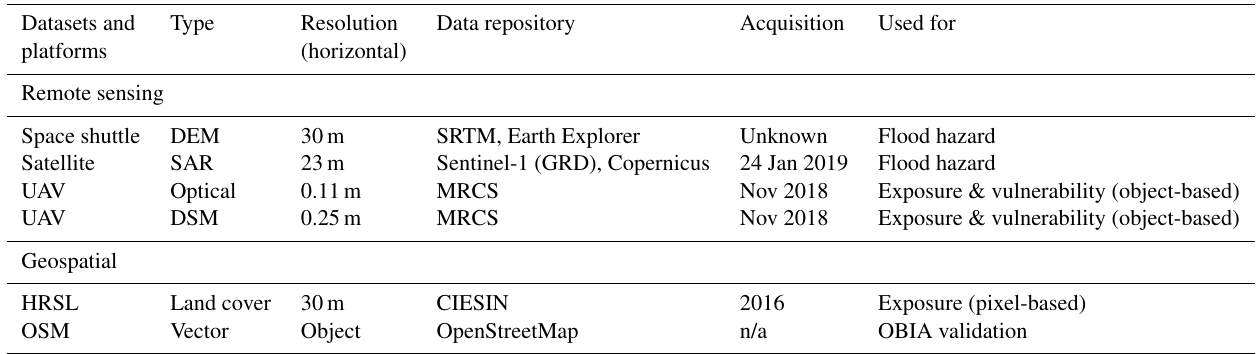
Table 1. Available datasets in this research. Abbreviations: digital elevation model (DEM), digital surface model (DSM), ground range detected (GRD), Malawi Red Cross Society (MRCS), OpenStreetMap (OSM) and Shuttle Radar Topography Mission (SRTM) synthetic aperture radar (SAR).